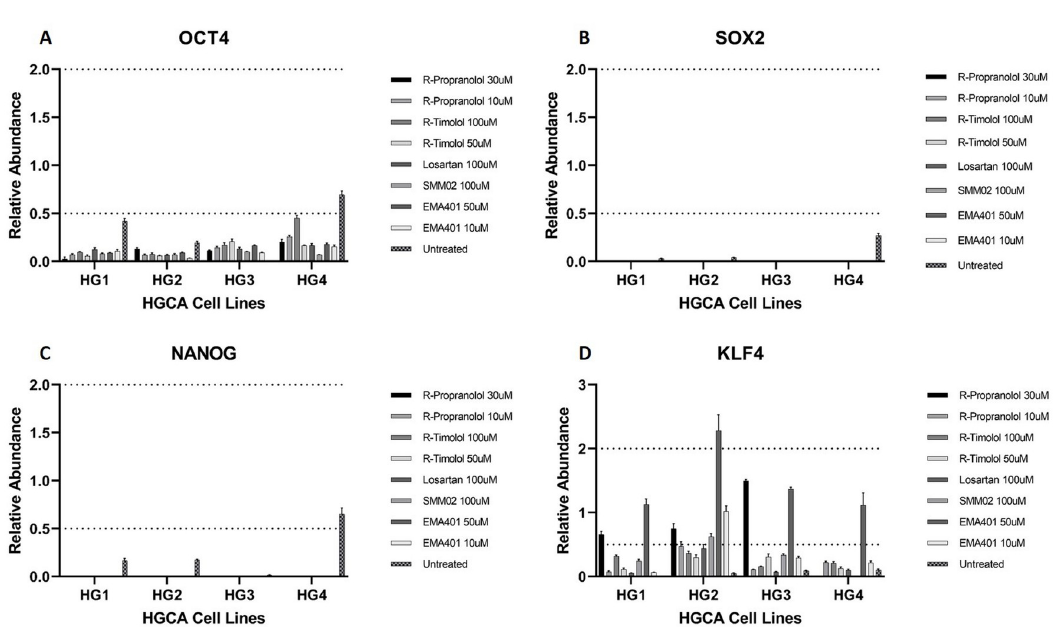
Fig 10. mRNA levels of stemness-associated markers in HGCA-derived cell lines treated with RASIs. RNA was extracted from 4 high-grade colon adenocarcinoma (HGCA)-derived primary cell lines that had been exposed to RASIs, as well as untreated controls, and the abundance of OCT4 (A), SOX2 (B), NANOG (C) and KLF4 (D) mRNA from these cell lines relative to the normal colon (NC) tissues was calculated (y-axis). Error bars show standard deviation from the average of technical replicates after removing outliers (CT value +/- 0.5 from average). Reproduced from [38] under a CC BY license, with permission from Munro MJ et al .